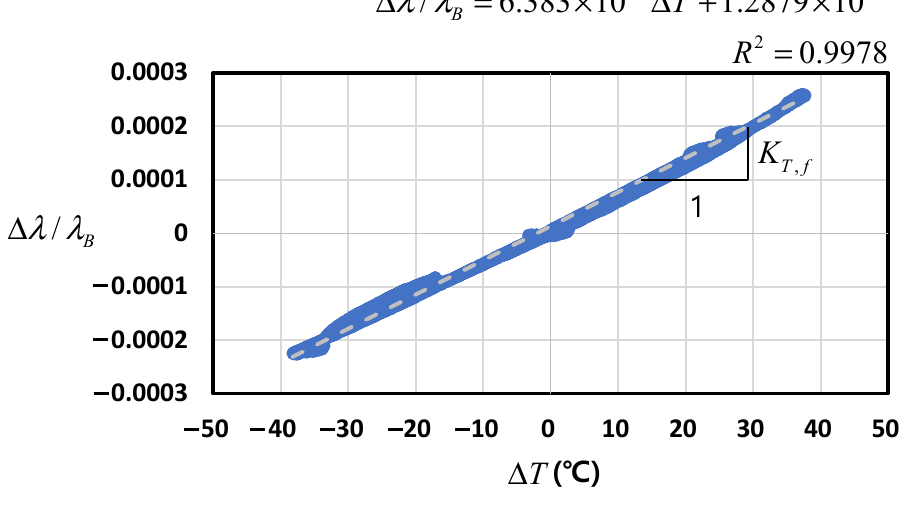
Figure 6. Wavelength–temperature relation of FBG.